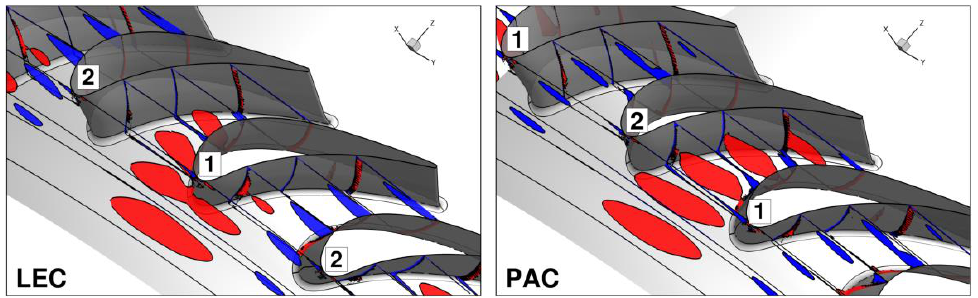
Figure 12. Axial component of vorticity (red—positive, blue—negative).